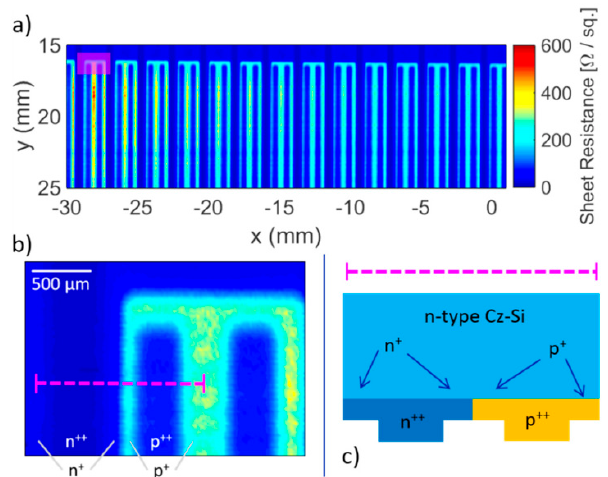
Figure 19. ( a ) A high-resolution sheet resistance map of a solar cell obtained with tip-based THz near-field microscopy. ( b ) Expanded view of a single finger. ( c ) Doping along the line marked in ( b ). Figure courtesy of Protemics GmbH.